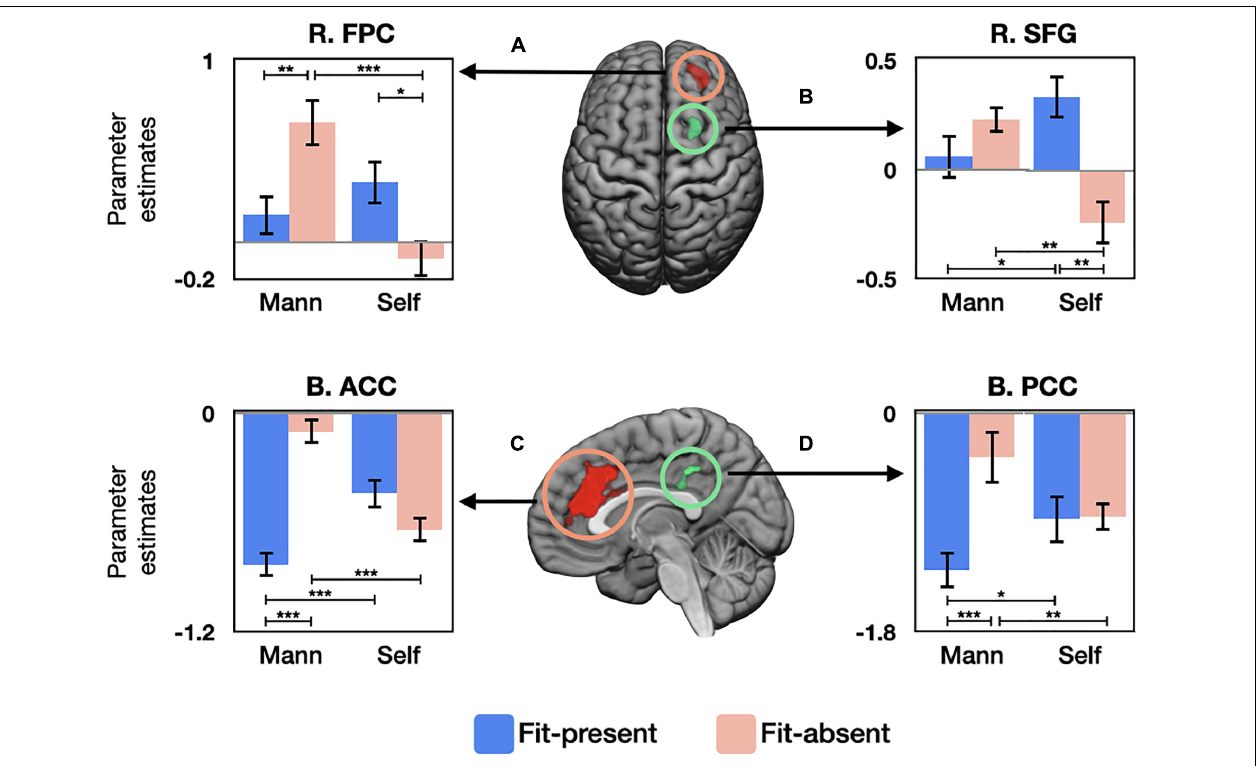
FIGURE 3 | Graphs of parameter estimates of neural regions. Panels (A–D) showing interaction effects between garment fit and product presentation type during purchase deliberation. Mann, mannequin; R., right; L., left; B., bilateral; FPC, frontopolar cortex; SFG, superior frontal gyrus; ACC, anterior cingulate cortex; PCC, posterior cingulate cortex. * P < 0.05, ** P < 0.01, *** P <